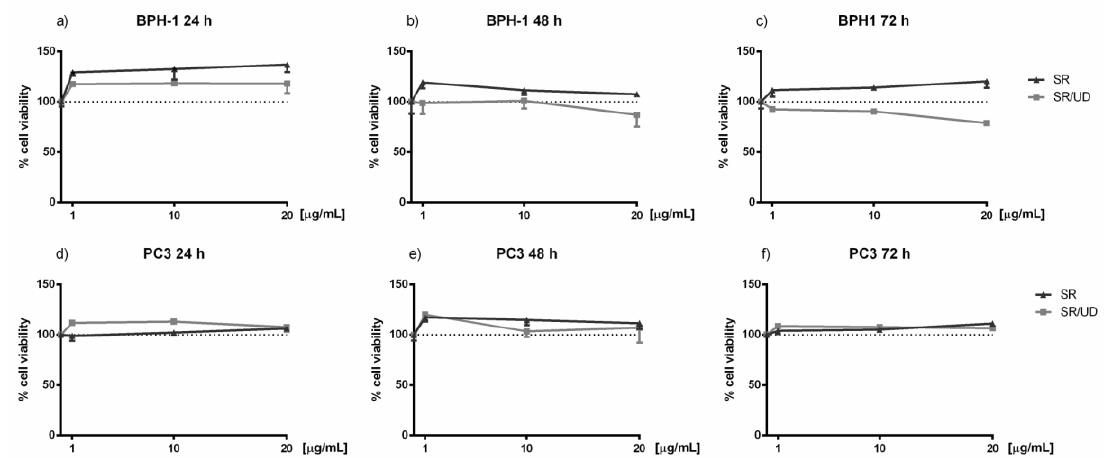
Figure 1. Effect of SR and SR/UD on BPH-1 and PC3 cell viability. BPH-1 cells treated with increasing concentrations of SR and SR / UD (1, 10, 20 µ g / mL) for ( a ) 24 h, ( b ) 48 h, ( c ) 72 h. PC-3 cells treated with increasing concentrations of SR and SR / UD (1, 10, 20 µ g / mL) for ( d ) 24 h, ( e ) 48 h, ( f ) 72 h. BPH-1 and PC3 cell viability was evaluated with the Crystal Violet Assay. Data represent the mean ± SEM ( n = 3). Di ff erences between various drug concentrations and control were analysed for each time point (24, 48, 72 h). The dashed line is the control.